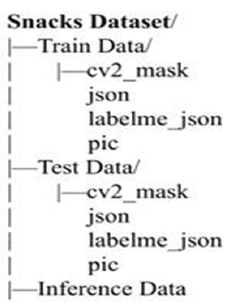
Figure 8. Data distribution for the Snacks dataset.